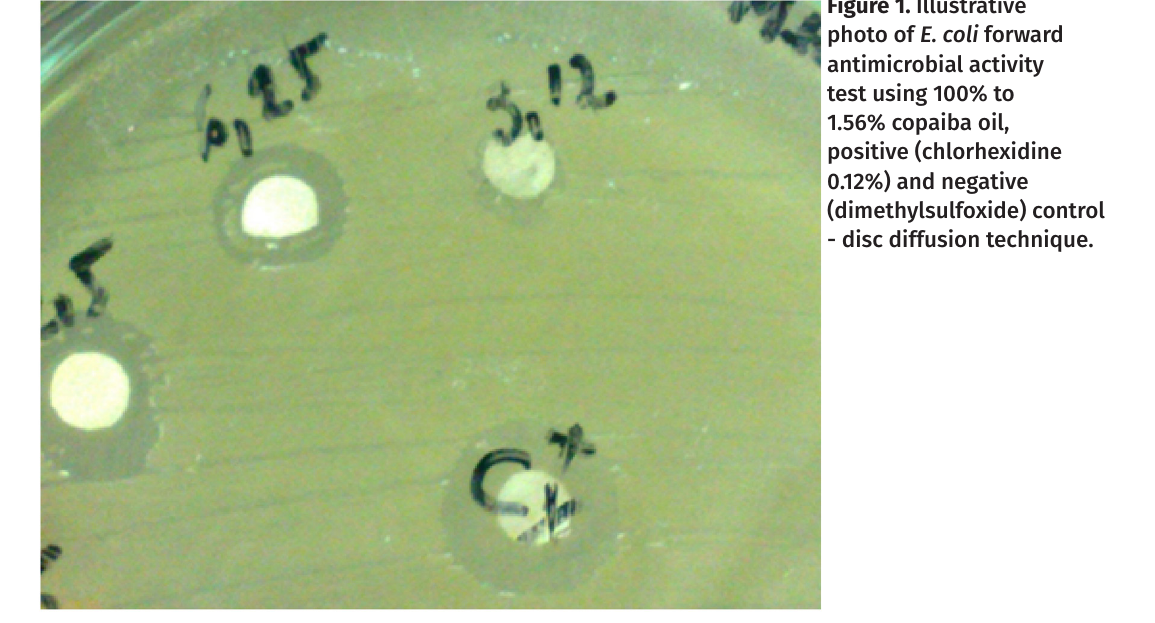
Figure 1. Illustrative photo of E. coli forward antimicrobial